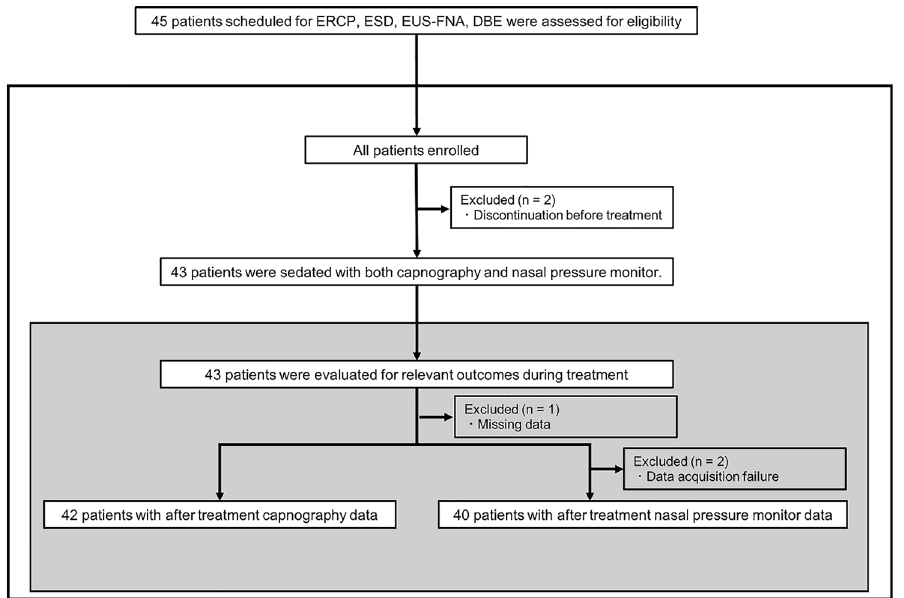
Figure 1. Study population and patient enrollment for